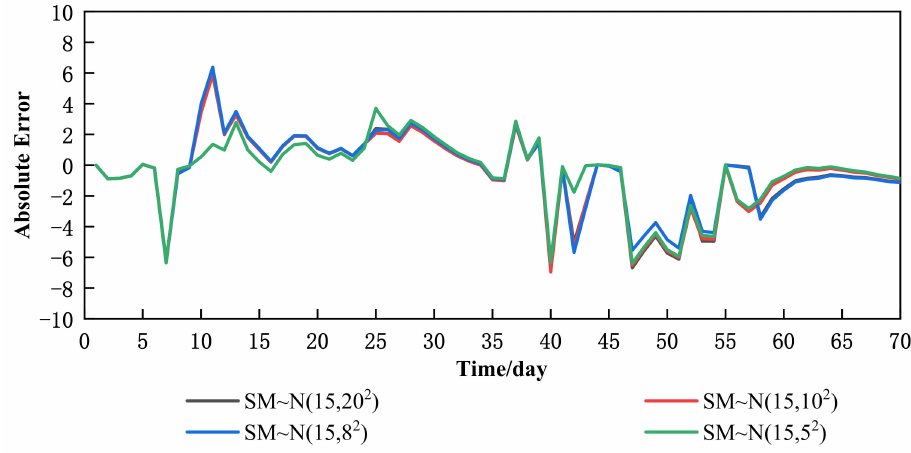
Figure 14. Absolute error variation of the assimilation under different variance values.